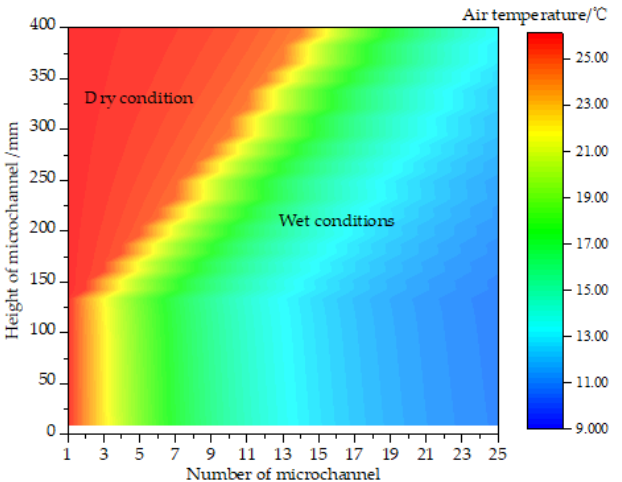
Figure 15. Air temperature out of the microchannels.